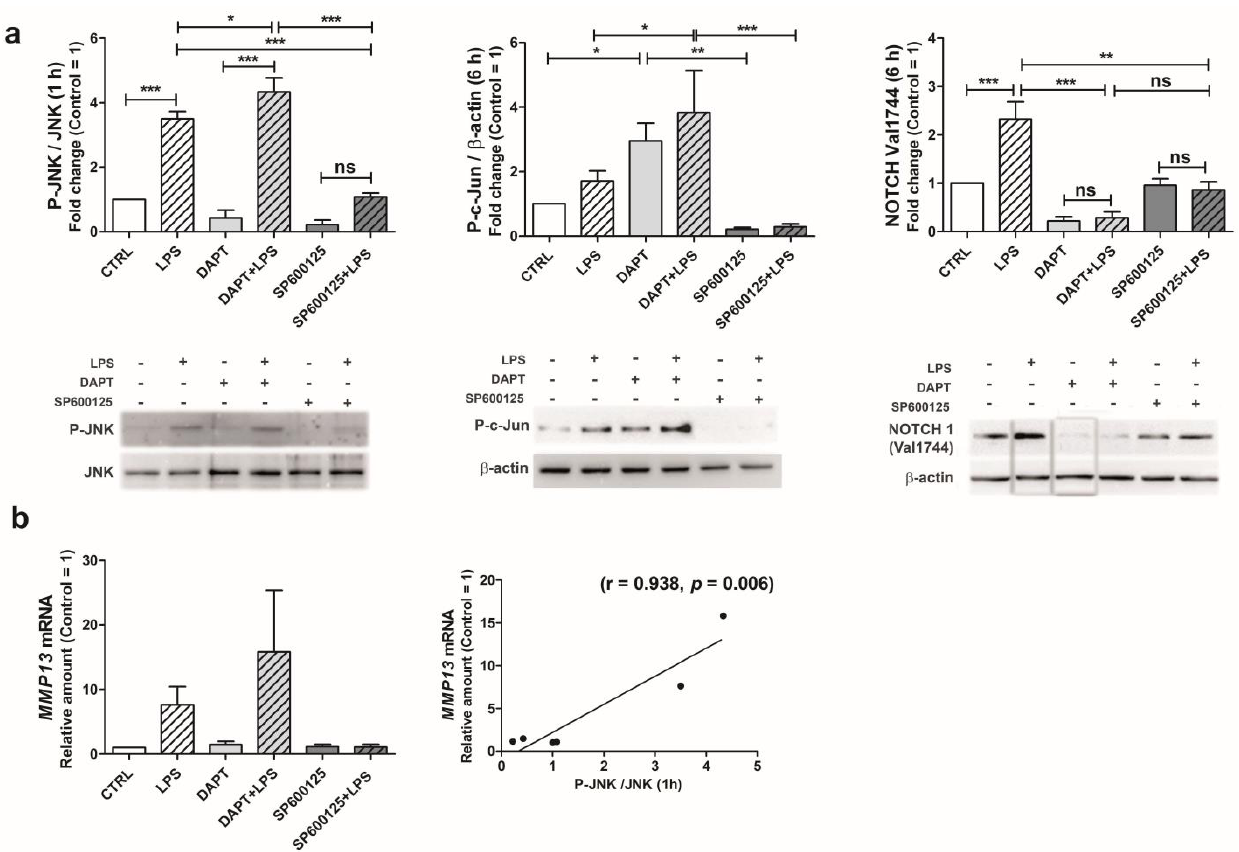
Figure 6. Activation of JNK pathway (phosphorylation of JNK and c-Jun) and of NOTCH1 (cleavage of Val1744) following LPS exposure and their effects on MMP-13 transcription. ( a ) In C28/I2, stimulation with LPS (1 h) strongly increased the levels of phosphorylated JNK and, after 6 h, that of cleaved NOTCH1. DAPT-mediated inhibition of NOTCH1 cleavage (Val1744) and activation enhances phosphorylated JNK after LPS exposure. Representative Western blots are shown for P-JNK ( n = 4), P-c-Jun ( n = 7) and NOTCH1 Val1744 ( n = 3) In the latter case, rearrangement (switch) of LPS and DAPT lanes was performed for consistency with the other Western blots (see Supporting information